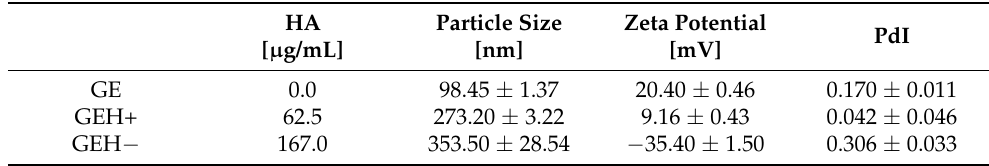
Table 1. Size, zeta potential and PdI of NPs with/without HA addition.